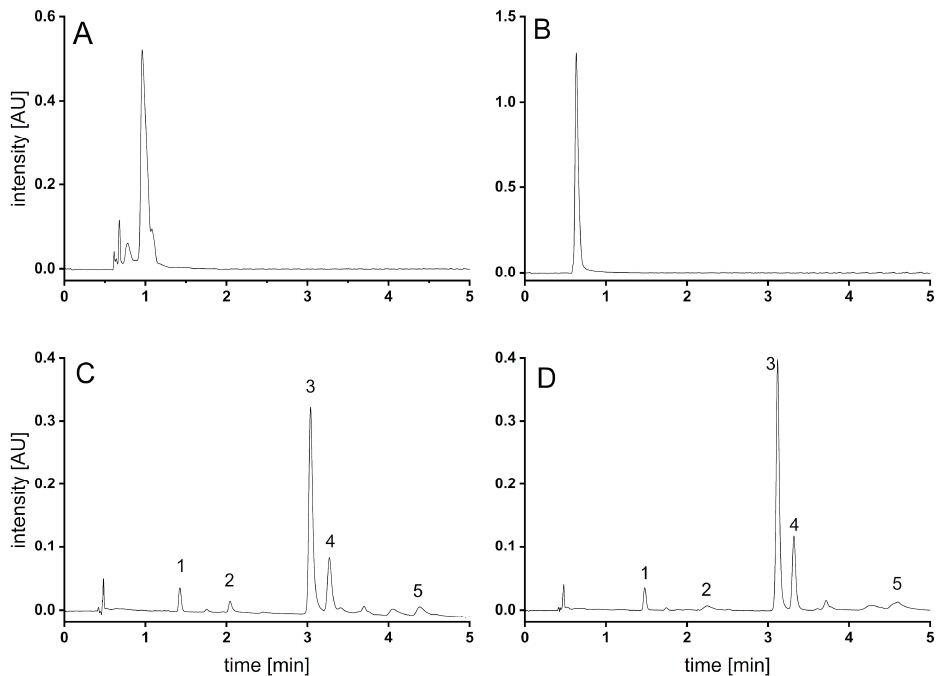
Figure 3. Influence of different parameters on the SFC-separation of the test solution: using a Viridis ® BEH ( A ) and Viridis ® HSS C18 SB column ( B ), adding 10% isopropanol to the modifier ( C ), using 0.1% of DEA as an additive ( D ). All other parameters were optimal (see Figure 2). With stationary and mobile phases being defined, the optimal gradient was now searched. As already mentioned, DHCs represent unusual analytes for SFC due to their polarity, so the initial modifier concentration had to be rather high, or else no or only partial elution of the analytes occurred. Thus, beginning the analysis with 30% of 2.5 mM oxalic acid in methanol was a good starting point in terms of a fast separation. The optimal endpoint of the gradient was determined at 45%, resulting in well-resolved peaks in only